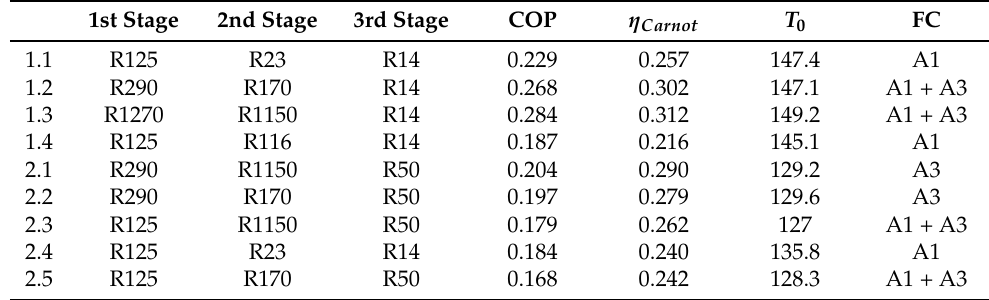
Table 5. Considered refrigerant sets with respect to the normal boiling temperature